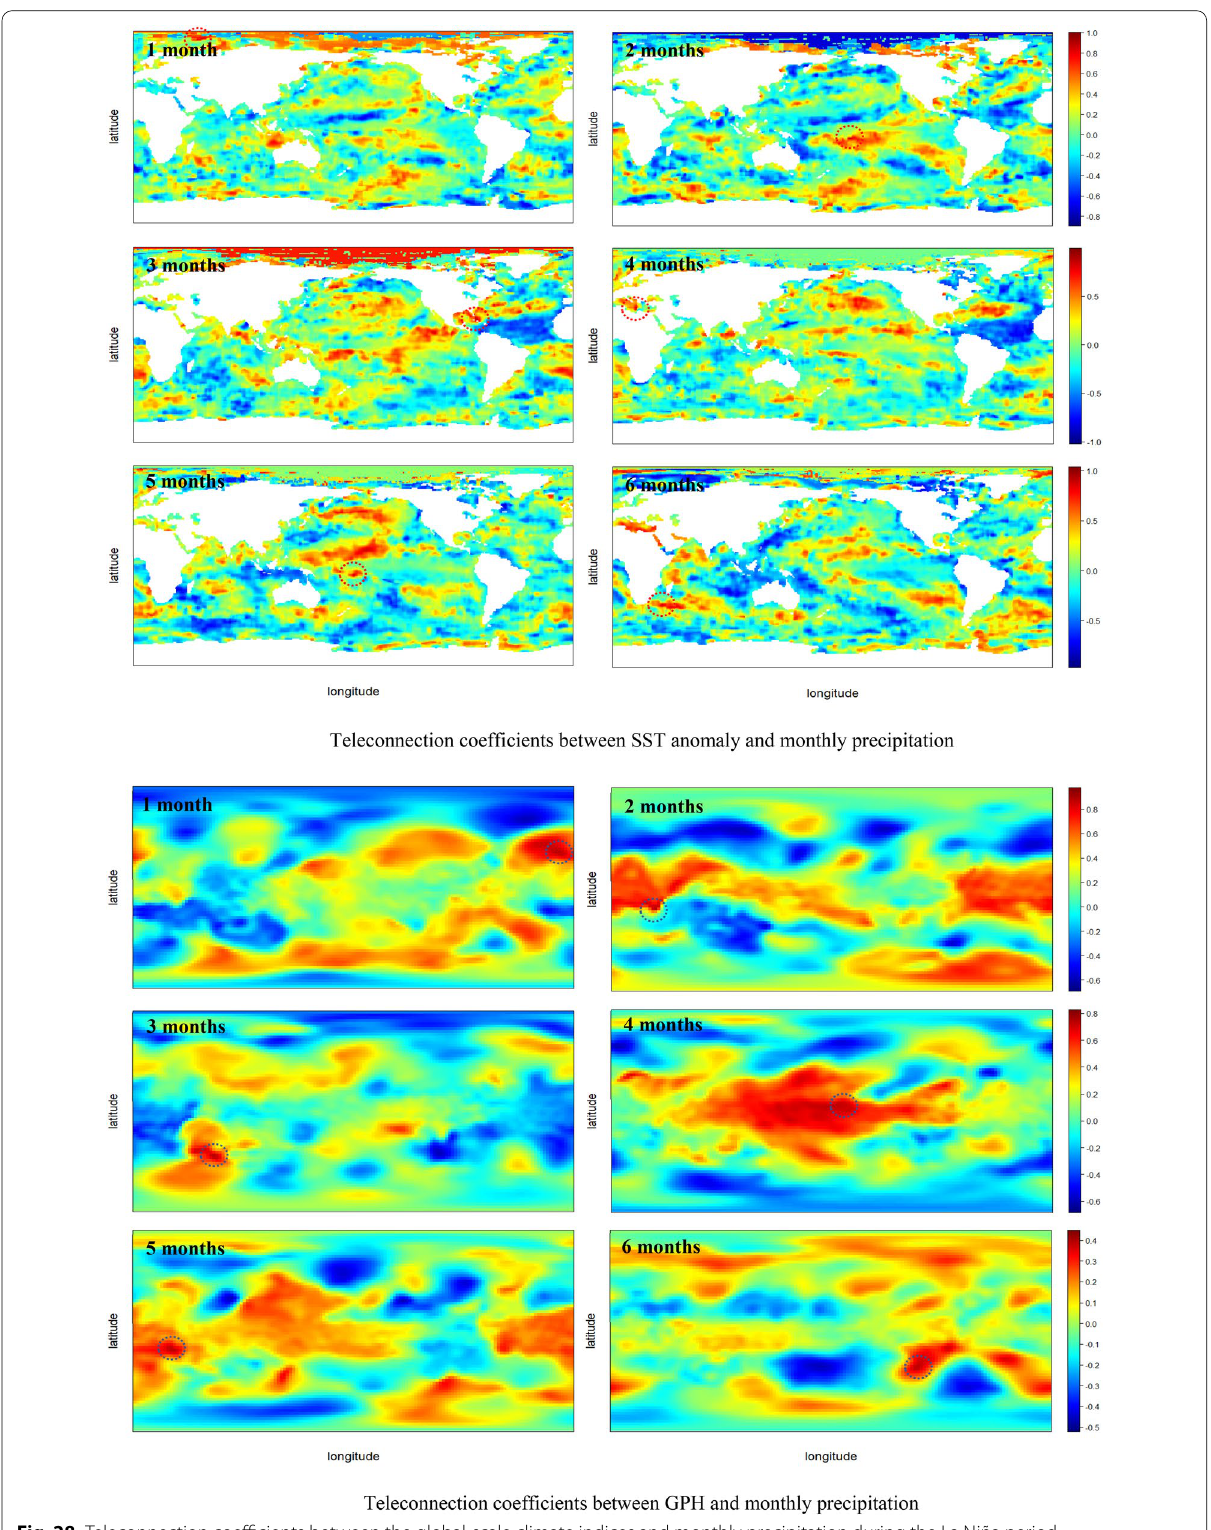
Fig. 28 Teleconnection coefficients between the global-scale climate indices and monthly precipitation during the La Niña